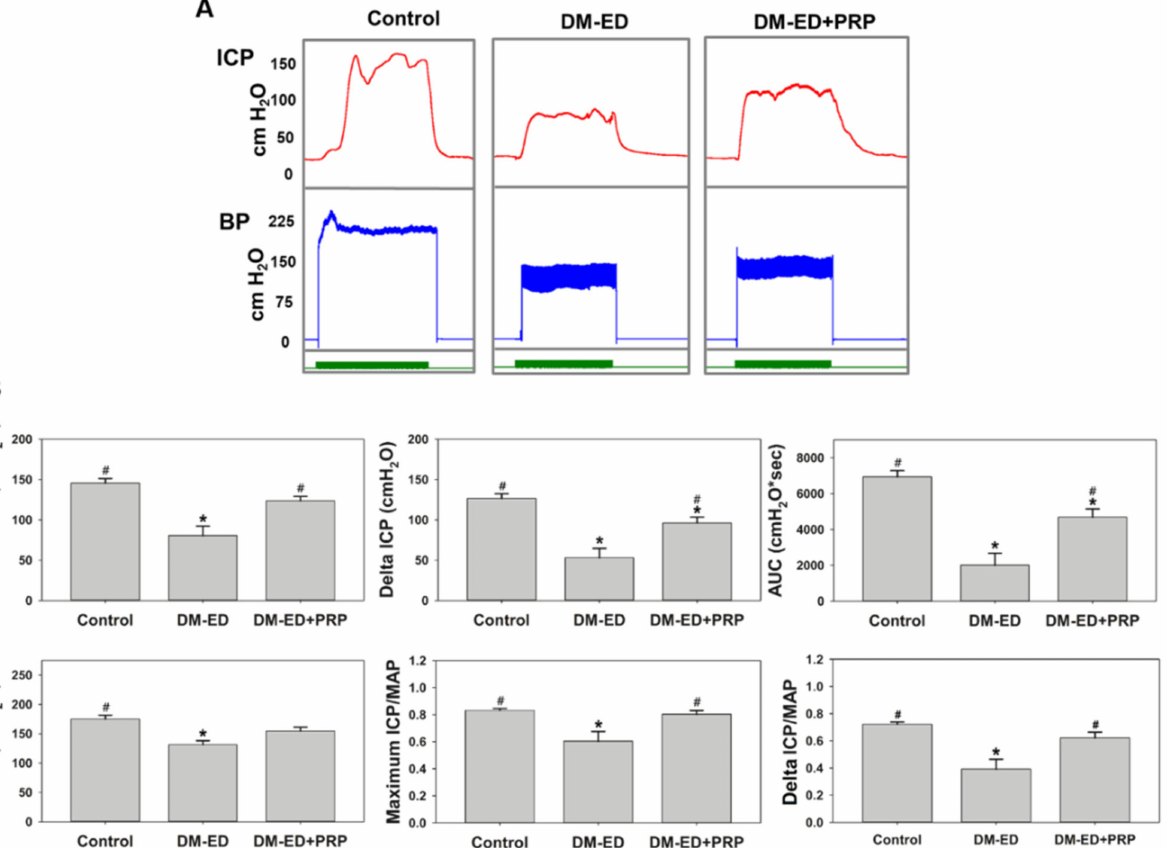
Figure 4. The erectile function parameters were compared after four weeks of platelet-rich plasma (PRP) or saline treatment. ( A ) Recordings of intracavernous pressure (ICP) and blood pressure (BP) in control, DM-ED, and DM-ED + PRP rats. Control, DM-ED, streptozotocin (STZ)-induced DM with ED and treated with saline; DM-ED + PRP, STZ-induced DM with ED and treated with PRP. ( B ) The quantitative results of an erectile function parameter (Mean arterial pressure, ICP, and AUC) were calculated for each group (control, DM-ED, and DM-ED + PRP rats). * p < 0.05 when compared with control, # p < 0.05 when compared with DM-ED. (AUC—area under the curve; ICP—Intracavernous pressure; MAP—mean arterial